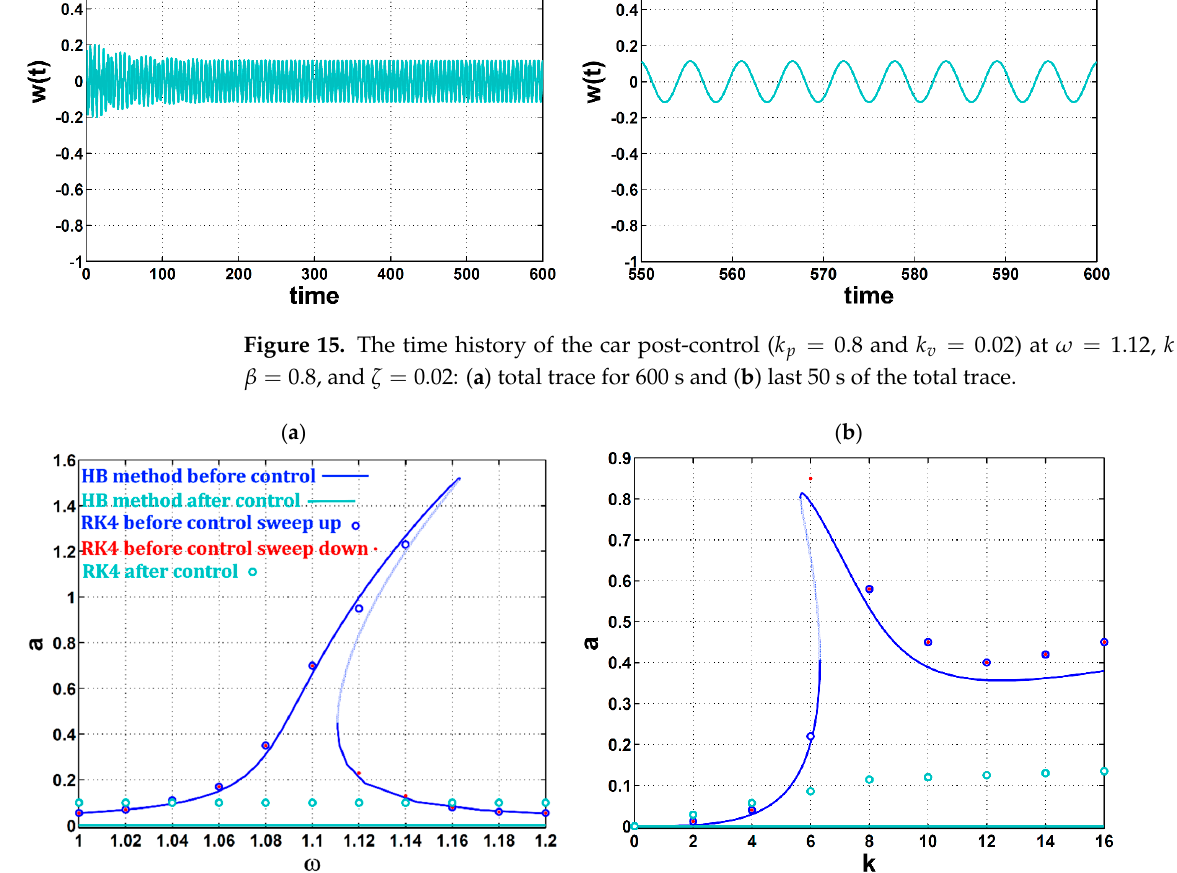
Figure 16. A comparison between the HB analytical solution (solid curves) and the RK4 numerical solution (circles and dots): ( a ) frequency-response curve a vs. ω at k = 7 and ( b ) force-response curve a vs. k at ω =